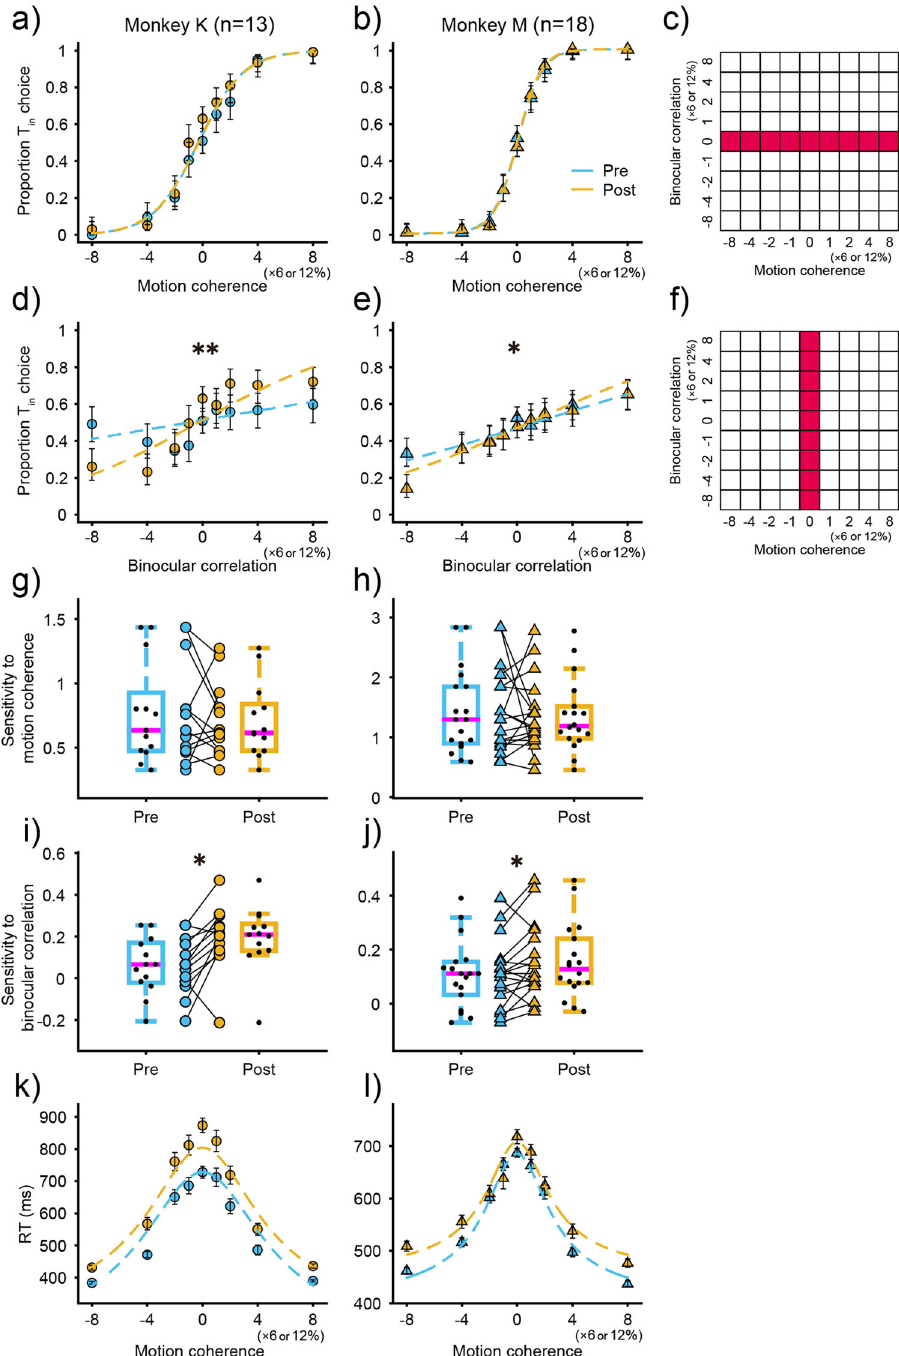
Fig. 3 Effects of ketamine on choice and reaction time for the direction-discrimination task. Psychometric function before (blue) and after (yellow) ketamine administration for monkey K ( a ) and monkey M ( b ). Proportion Tin choice is plotted as a function of motion coherence with 0% binocular correlation. Stimuli used to plot psychometric functions are shown as a grid ( c ). Data were combined across 13 experiments for monkey K and 18 experiments for monkey M. Lines denote logistic regression fi ts, and error bars indicate 95% con fi dence interval. d – f Proportion Tin choice is plotted as a function of binocular correlation with 0% motion coherence. Asterisks indicate statistically signi fi cant results ( Z test; ** p < 0.01, * p < 0.05). Conventions are the same as in ( a – c ). Boxplots show the effects of ketamine on sensitivity to motion coherence for the direction-discrimination task in monkey K ( g ) and monkey M ( h ). Sensitivity was derived from the slope of the psychometric function fi tted for each experimental data as shown in ( a – c ). Boxplot conventions are the same as in Fig. 2. i , j Boxplots show the effects of ketamine on sensitivity to binocular correlation for the direction-discrimination task. The conventions are the same as in Fig. 2. Sensitivity was derived from the slope of the psychometric function fi tted for each experimental data as shown in ( d – f ). Asterisks indicate statistically signi fi cant results (Wilcoxon signed-rank test; * p < 0.05). Chronometric function before (blue) and after (yellow) ketamine administration for monkey K ( k ) and monkey M ( l ). RTs are plotted as a function of motion coherence. Lines denote drift diffusion model fi ts using all 6 parameters, and error bars indicate SEM. Conventions are the same as in ( a , b